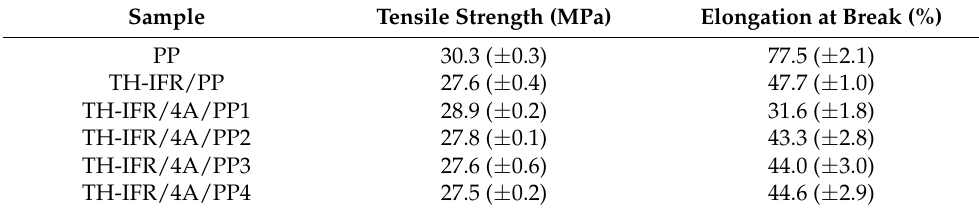
Table 5. The mechanical properties of pure PP and FR PP composites.